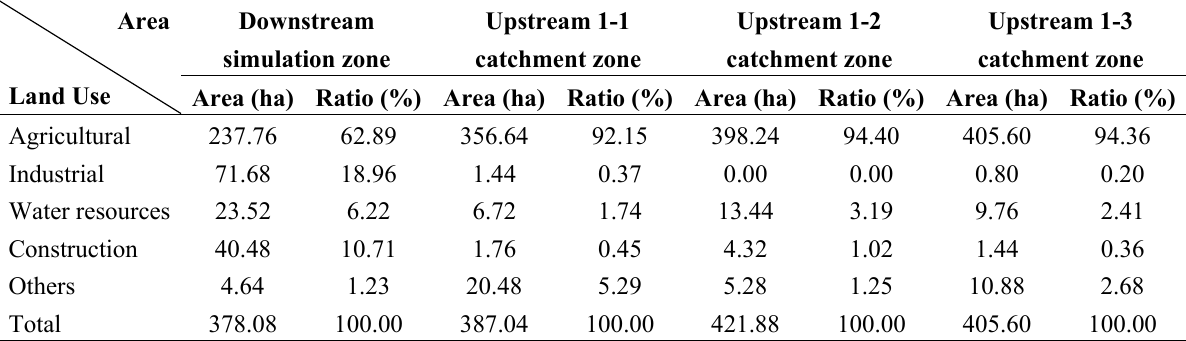
Table 1. The land use ratio and the surface area of the downstream simulation zone and the upstream catchment area of the Po Cheng Ken Stream.